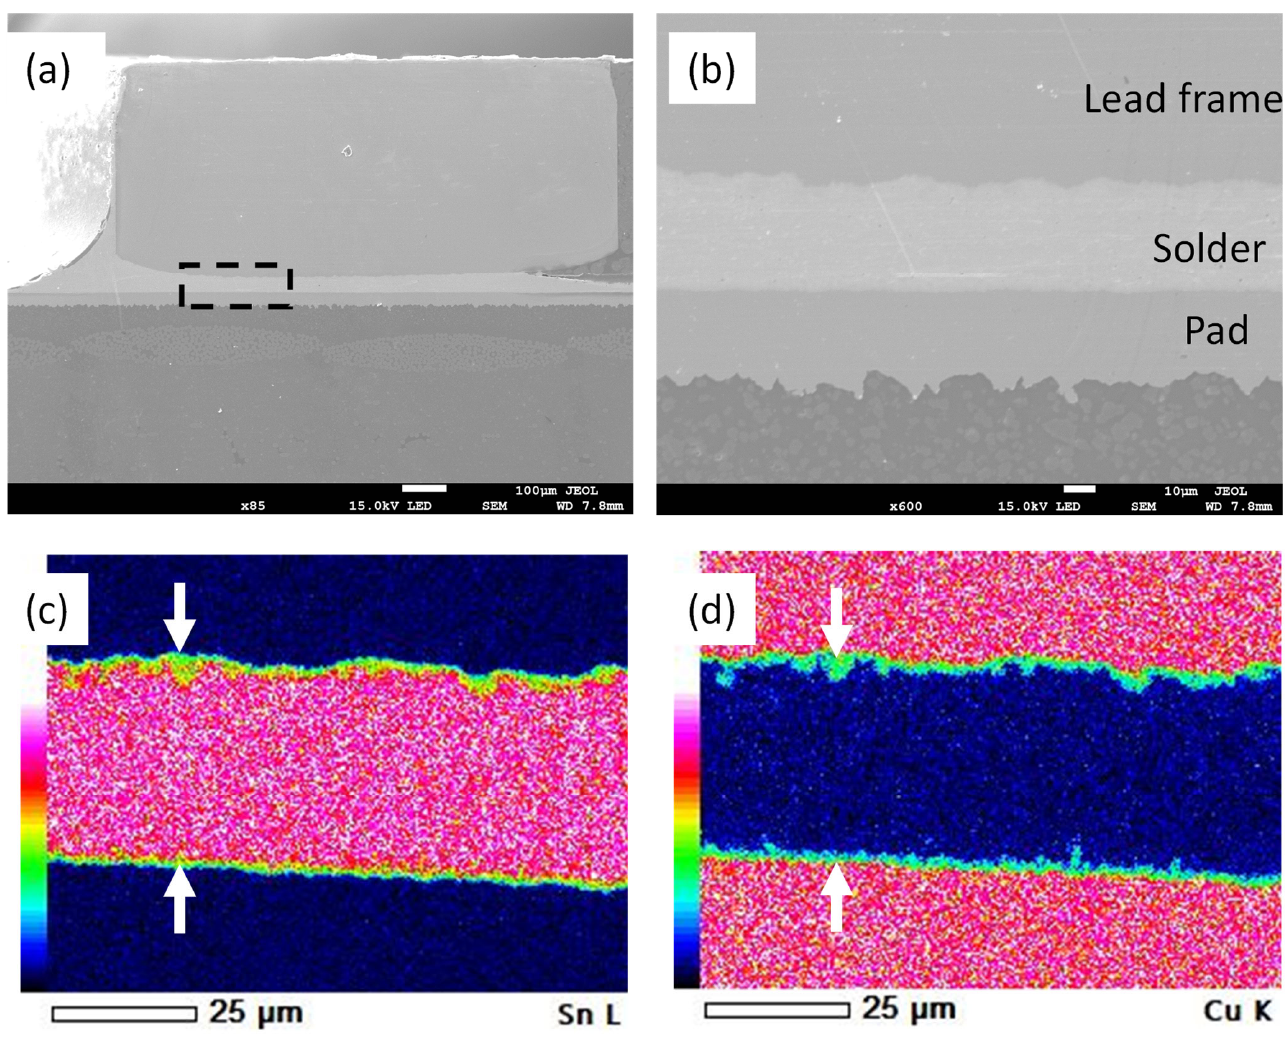
Figure 6. SEM image of position 1 in Figure 5. A low magnification image ( a ), a magnified image of the dashed square in Figure 6a ( b ), and EDS mapping images of Sn ( c ) and Cu ( d ) for Figure 6b. Each white arrow indicates position of alloy layer.